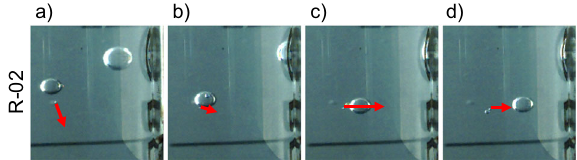
Fig. 5 Representative time stamps of a bubble dragging event for the R-02 MilliQ water solution in microgravity. In a , the larger bubble approaches the smaller in its path toward the magnet, reaching the point of closest proximity in b . In c , the smaller bubble is accelerated by the wake of the larger, reducing its speed once the wake moves away in d . The red arrow indicates the velocity of the smaller bubble as the larger one drags